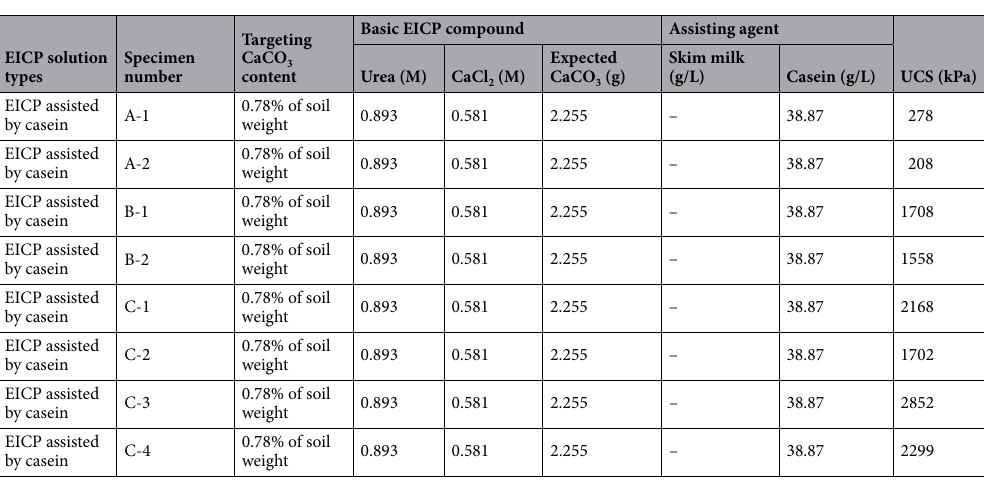
Table 3. Specimen information for EICP treatment and corresponding UCS results of the optimization study of curing and drying strategies. All specimens involves 2.6 g/L of urease enzyme. Specimens of case A were dried at 105 °C after the mixing process. Specimens of case B were cured at 25 °C for 72 h and then dried at 105 °C. Specimens of case C were cured at 25 °C for 72 h and then dried at 40